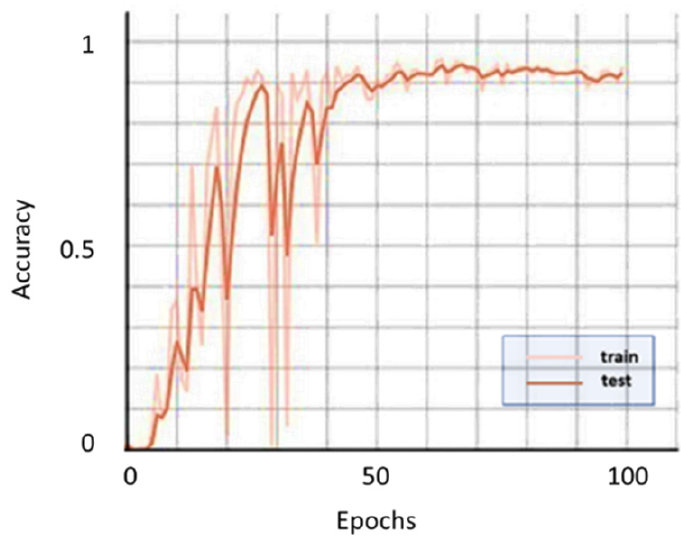
Figure 12. Learning curves of the CNN-based recognition Model.